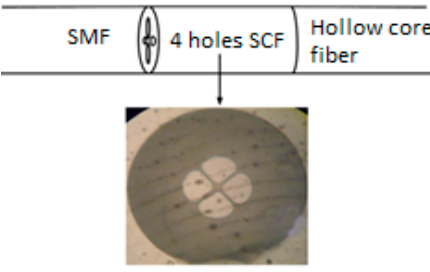
Figure 14. Schematic of the Fabry-Perot cavity as a sensing head with cross-sectional microscopic image; the four holes suspended core fiber section forms the Fabry-Perot cavity (Reproduced from [60], with the permission of Elsevier publishing).